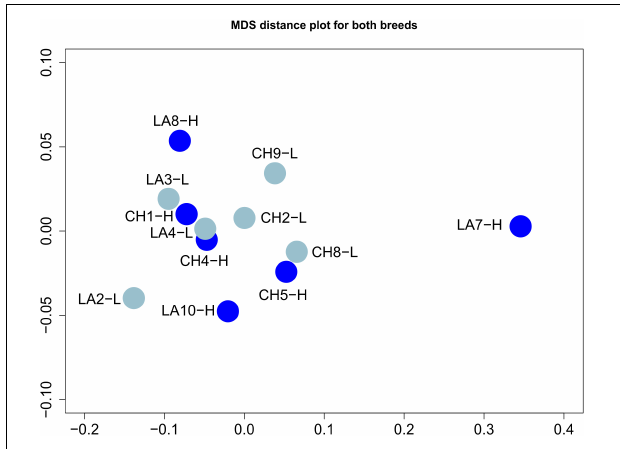
FIGURE 1 | Multidimensional scaling analysis of mammary gland transcriptome profiles using the FPKM (Fragments Per Kilobase Million) values for the 27,327 identified genes. Samples are colored according to their yield (light blue for low yield; blue for high